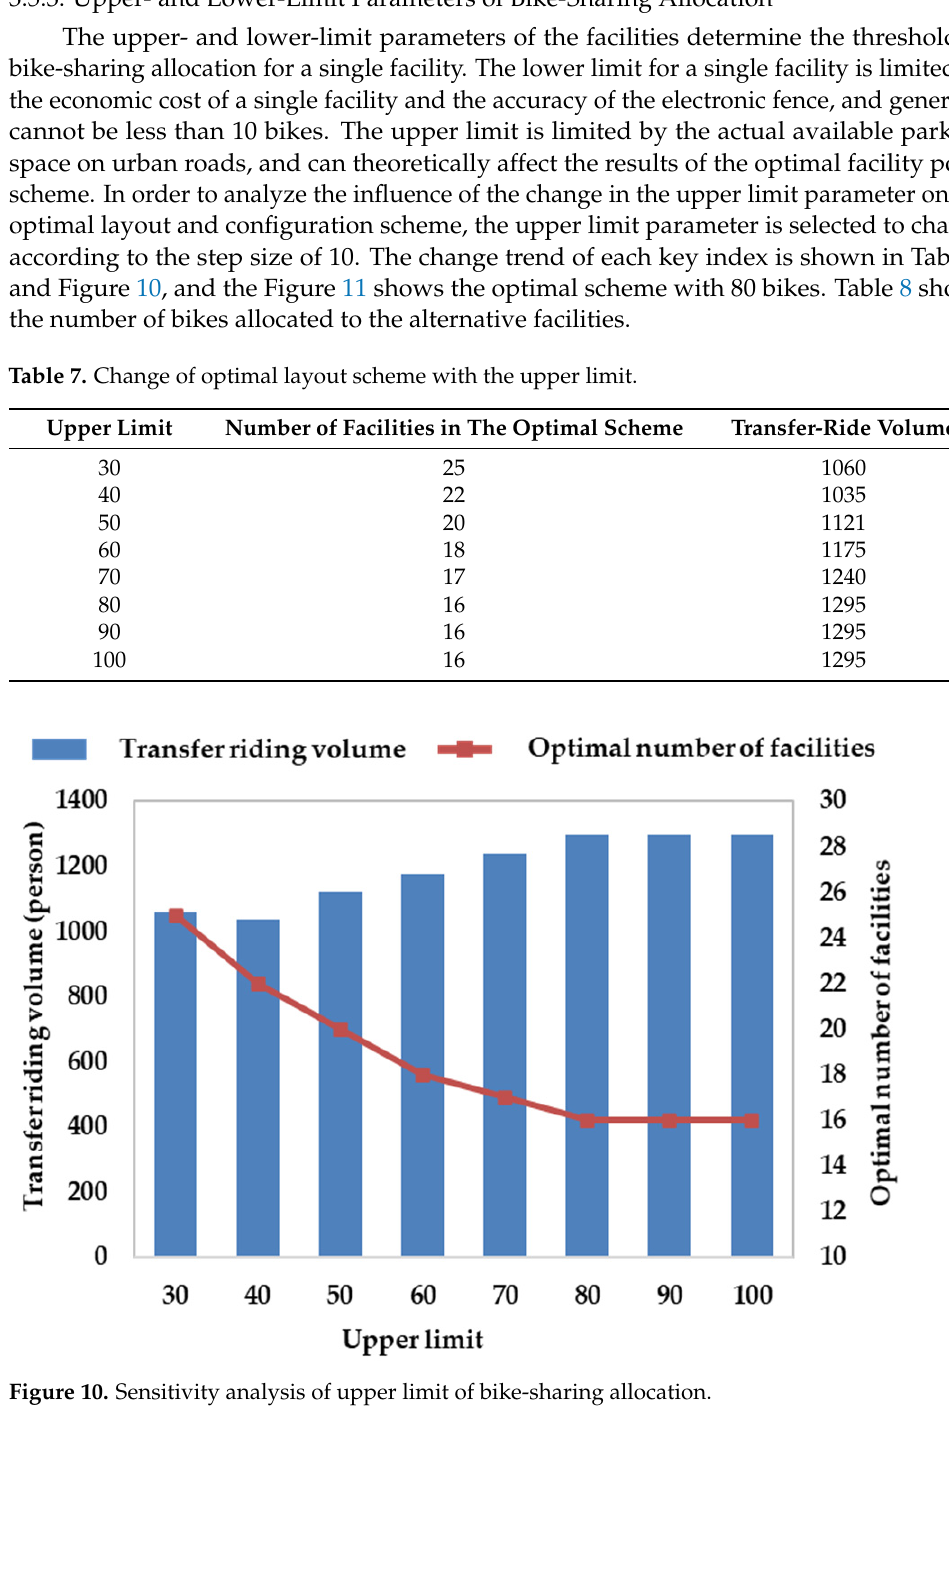
Figure 11. Optimal scheme of bike-sharing facilities with an upper limit of 80.